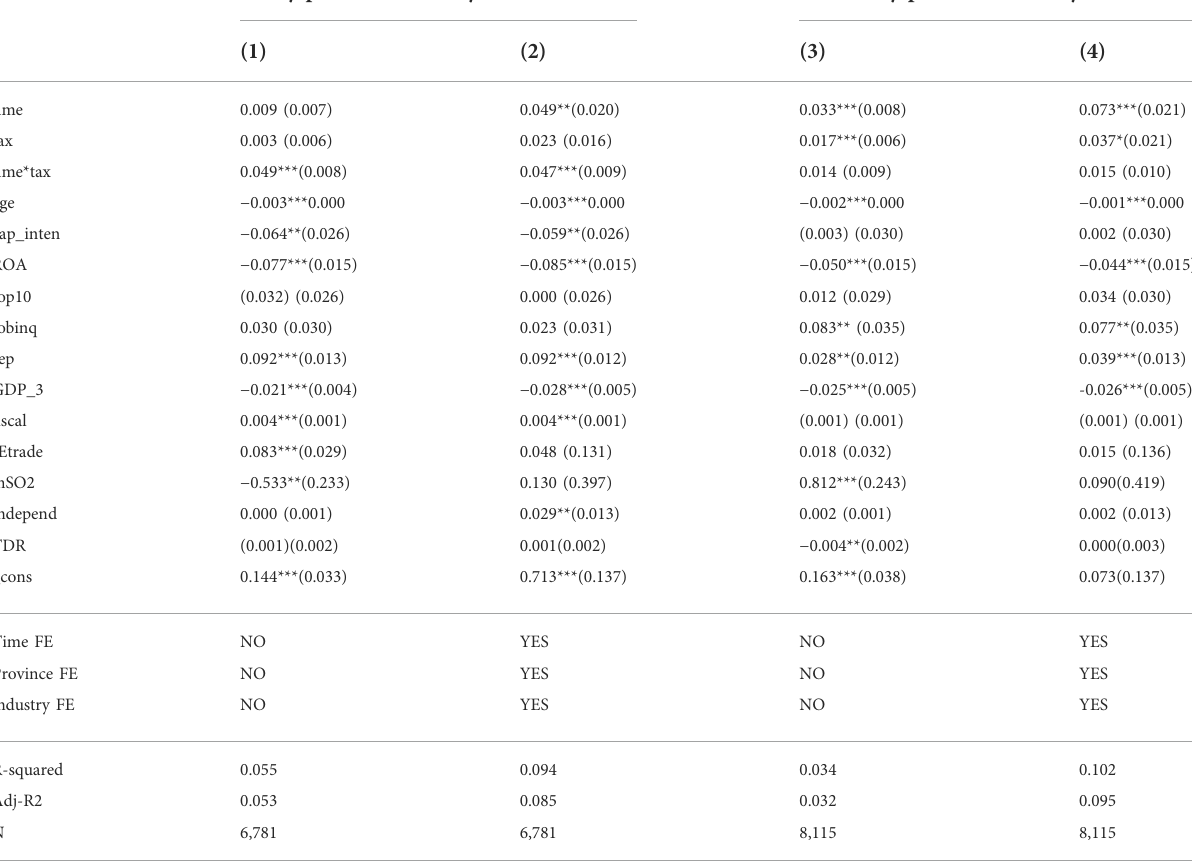
TABLE 12 Robustness test regression results: Degree of industry